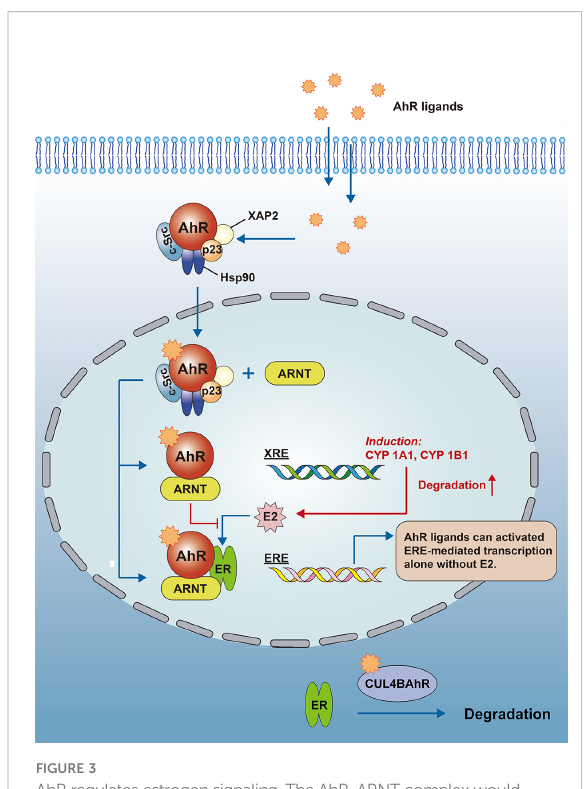
FIGURE 3 AhR regulatesestrogensignaling. TheAhR-ARNTcomplex would interactdirectly withtheERandbindtotheEREtoactivate transcription,whilethe AhR-ARNTcomplexalsoinhibits E2bindingto theER. At thesame time, AhRcanfunctionasanE3 ubiquitin ligaseto promotethedegradationofthesexhormonereceptor(CUL4BAhRis a complexthatconsistsof AhR, ARNT,CUL4B,TBL3,DDB1andRbx1, theAhRplaysaroleasanadapterforspeci fi csubstrates).AhR, Aryl hydrocarbonreceptor; ARNT, Aryl hydrocarbonreceptornuclear transportprotein;XRE,xenobioticresponseelement;ERE, estrogen responseelement;CYP,CytochromeP450;E2, estradiol;DDB1, damage-speci fi cDNAbindingprotein 1;TBL3, transducinbeta-like